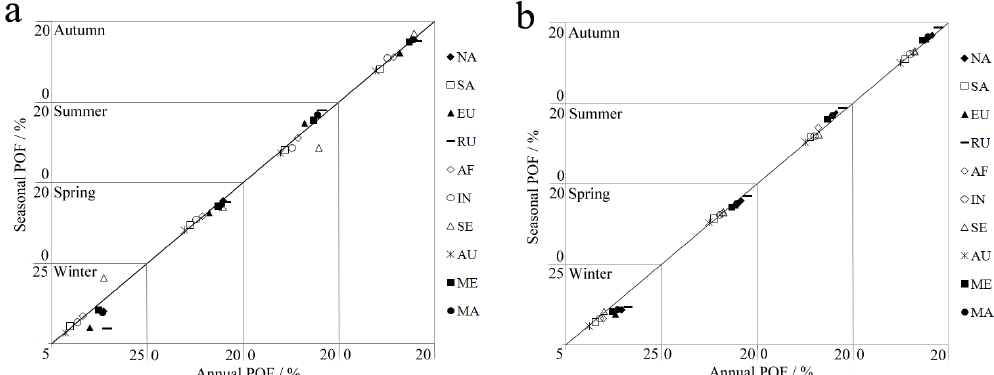
Figure 8. Seasonal variation on mercury deposition contributions over other regions from East Asia (EA): (a) mercury dry deposition; (b) mercury wet deposition. Four period zones are defined (winter, spring, summer, and autumn) and each period zone has its own ranges of POF values. The line is for equivalence between seasonal POF and annual